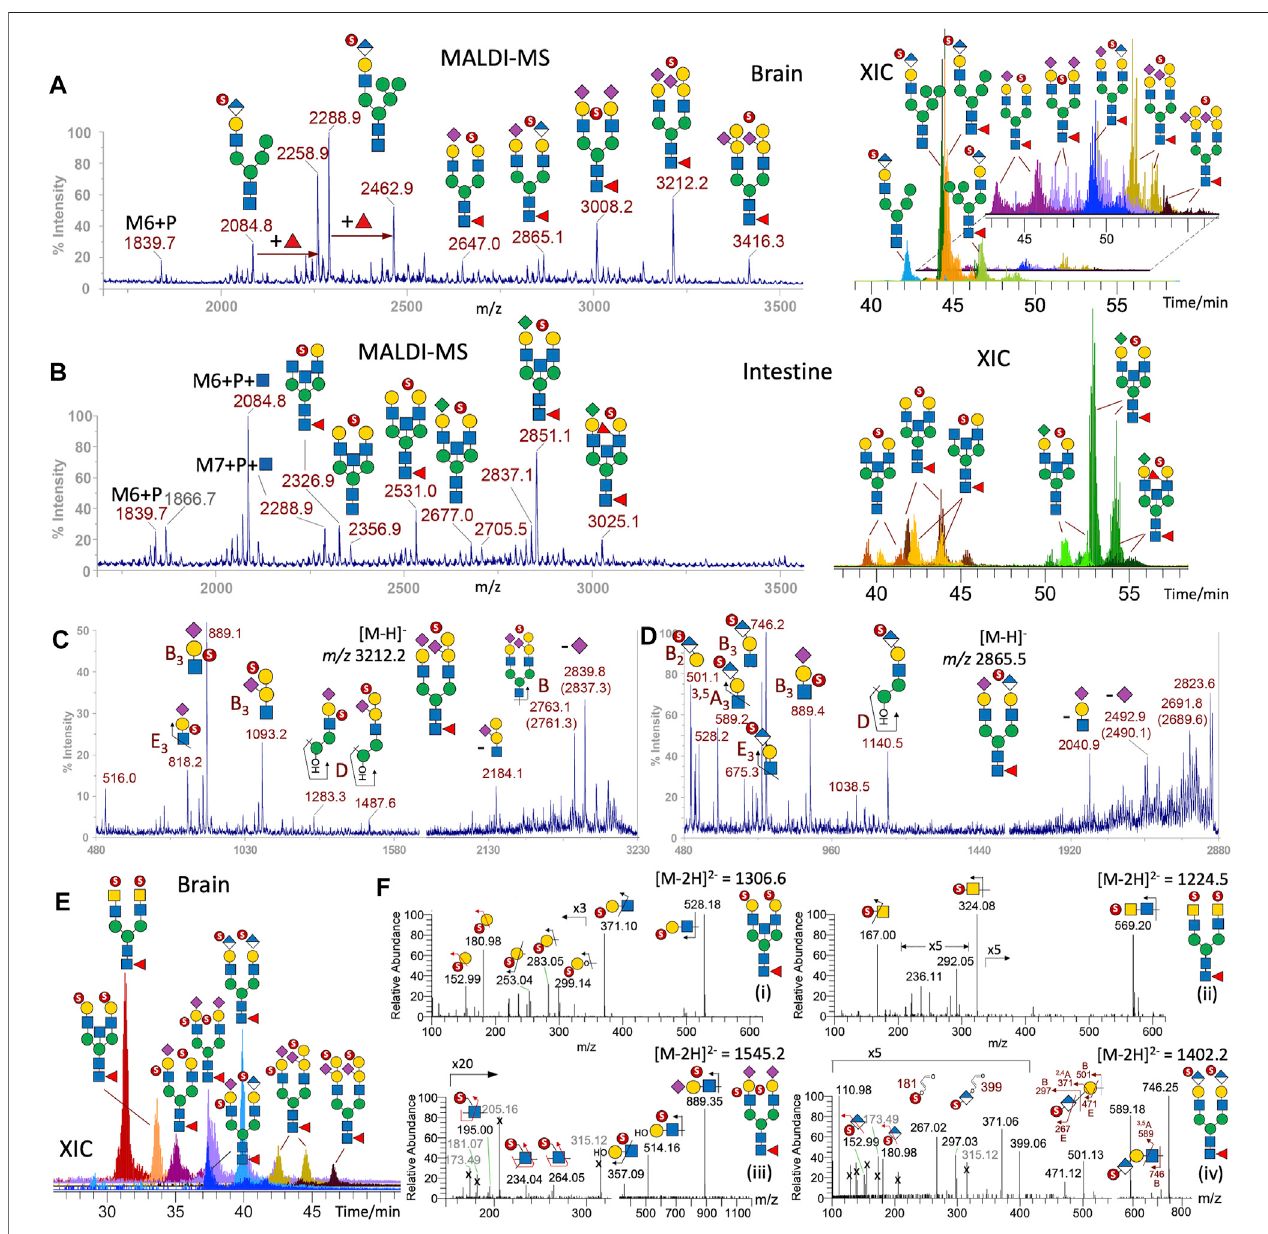
FIGURE 3 | Sulfated N-glycans of adult zebra fi sh. MALDI-MS screening revealed the presence of permethylated monosulfated N-glycans in the enriched sample fractions derived from brain (A) and intestine (B) but not ovaries. XICs of each of the major monosulfated N-glycans were overlaid to produce the LC-MS pro fi les (right panels) . The lower abundant structures found in the brain were separately plotted and further magni fi ed for better visualization. MALDI-MS/MS on two of the major sulfated brain N-glycans at m/z 3,212 (C) and 2,865 (D) afforded characteristic ions (Yu et al., 2009) that support the assignment of the implicated sulfated glycotope as annotated. More detailed structural assignments including the location of sulfate were afforded by nano-LC-MS/MS analysis of the major disulfated N-glycans, the overlaid XICs of which is shown in (E) and the representative MS 2 spectra of doubly charged precursor in (F) . Terminal 3-O-sulfated Hex is collectively identi fi ed by diagnostic ions at m/z 153 and 181 together with the E 1 and B 1 ions at m/z 253 and 283 (F-i), terminal 4-O-sulfated HexNAc as found in sulfated LacdiNAc by 3,5 A 1 andB 1 ionsat m/z 167and m/z 324(F-ii),internalGlcNAc-6-O-sulfate insulfated NeuAc-Gal-GlcNAcbythediagnosticionsat m/z 195,234,and264(F-iii),and the 3-O-sulfated HexA in HNK-1 by ions described in the text (F-iv). A series of singly charged molecular ions from intestine (B) can be additionally assigned as oligomannose structures carrying Man-6-phosphate ± GlcNAc, and be distinguished from isobaric structures in the brain (A) containing instead sulfated HNK-1, based ondiagnosticMS 2 ions( SupplementaryFiguresS5,S6 ).Namingandcartoonrepresentationofcleavageionshavebeendescribedandfullyreferencedinourprevious work (Yu et al., 2009; Cheng et al.,